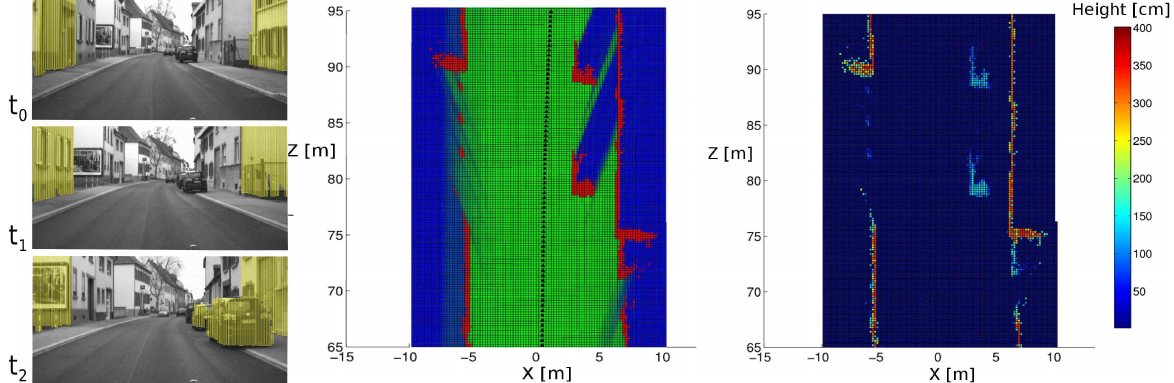
Figure 5: An exemplary mapping result is shown. On the left side the original images with the input data of three time steps are presented. The map in the center shows the results using the described approach. The color reveals occupied (red), free (green) and unknown (blue) areas of the environment. The stronger the color saturation the stronger the evidence of free , occupied or unknown . On the right side of the map an entrance gate, two parking vehicles and the building facades are mapped correctly. Furthermore, poles on the left side are presented, too. The cells ”behind” the vehicle have an unknown state. On the right side of the figure the height layer is shown. There, the color encodes the height from zero (dark blue) to about 4 m (dark red). The facades are about 4 m high; vehicles, the entrance gate and the poles have heights between 0.5-1.5 m.